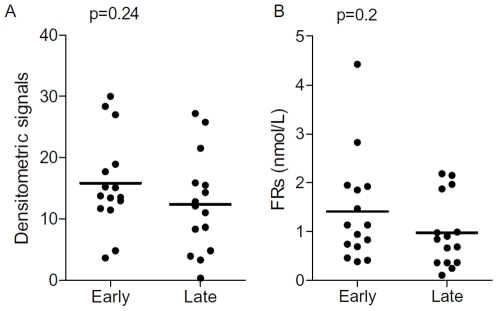
Levels of circulating FRα are similar in early and late stage ovarian cancer patients.Panels A and B shows the comparison between early and late stage densitometric and microfiltration assay signals, respectively. Each data point represents a unique individual and the horizontal line represents the mean. p values shown were calculated using a Student's T test.